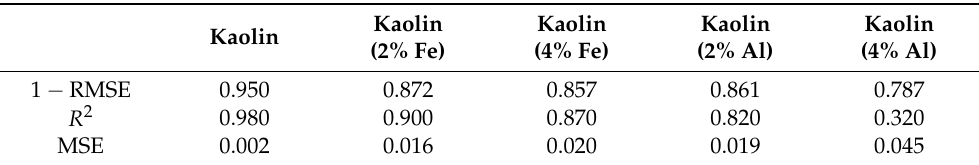
Table 7. MLR regression similarity measurements of FR using leachate parameters of different clay soil